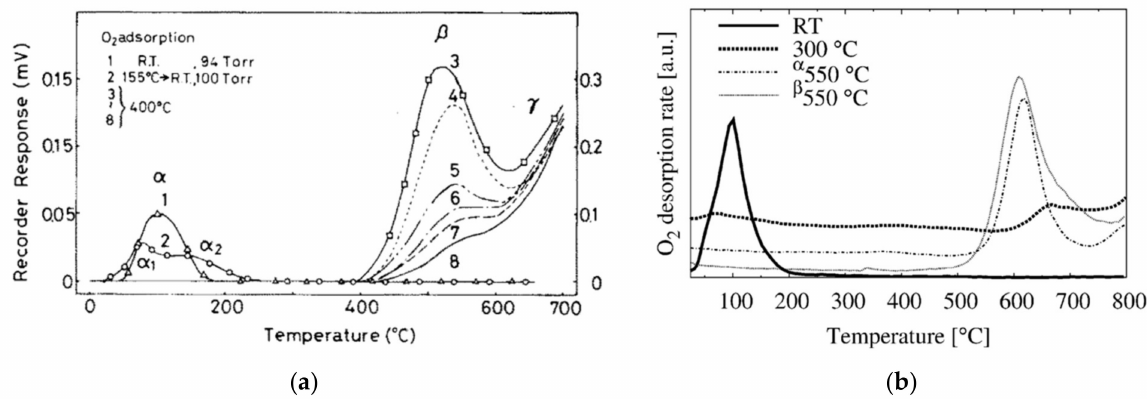
Figure 4. TPD chromatograms of O 2 desorption from SnO 2 . ( a ) Traces 1–2 correspond to the low-temperature adsorption following the evacuation at 700 ◦ C. Traces 3–8 correspond to oxygen dosing at 400 ◦ C and pressures of 99, 48, 16, 6, 3 and 2 Torr, respectively. Reproduced with permission from Reference [50]. ( b ) TPD of SnO 2 after exposure to O 2 . Trace α denotes sample cooled in UHV, while β denotes cooling in O 2 background. Reproduced with permission from Reference